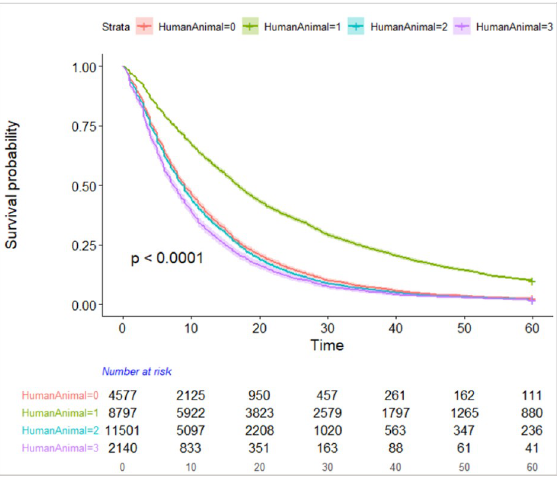
Fig 2. KM survival curve of time to first publication for human and animal research codes.